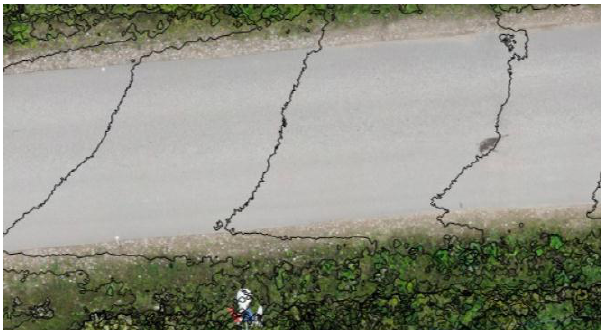
Figure 12. Orthophotoplan with contour